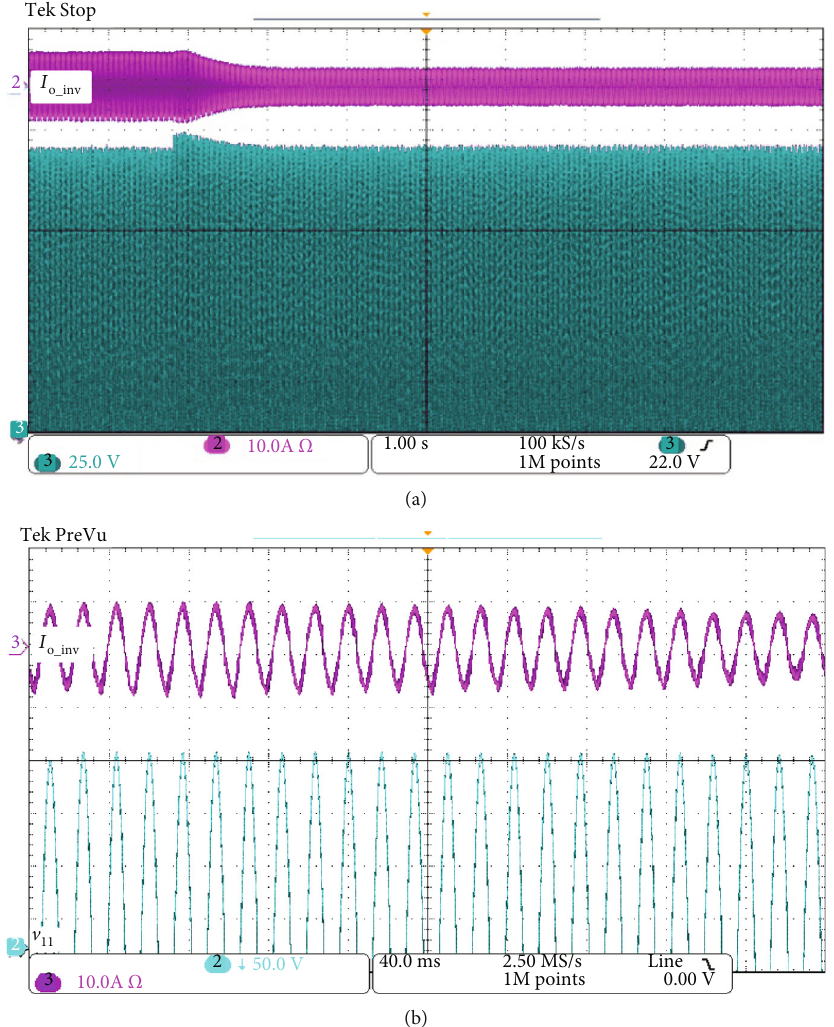
Figure 10: Power variation, for positive deviation. From top to bottom: current in residence 11 ( I ( V , 25V/div). (a) Full transition, time 1s/div; (b) zoom, time 11